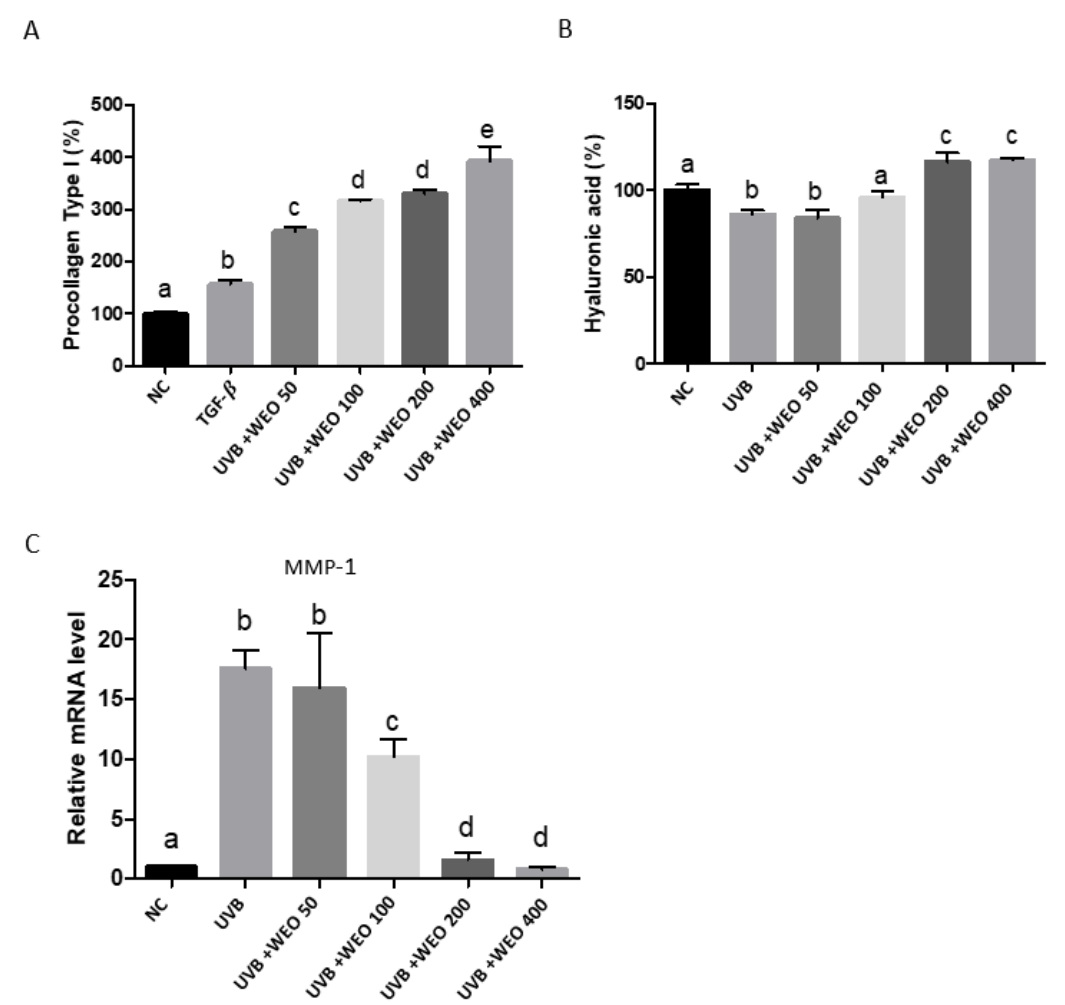
Figure 4. Changes in skin-damage-related factors in human skin cell lines. ( A ) Procollagen synthetic enhancement measurement in CCD-986sk cells by microplate reader. ( B ) Hyaluronic acid measurement in HaCaT cells. ( C ) Measurement of matrix metalloproteinase-1 (MMP-1) mRNA expression in CCD-986sk cells by qRT-PCR. Values with different letters are significantly different by ANOVA followed by the Newman–Keuls multiple range test ( p < 0.05). NC: normal control, UVB: Ultraviolet, WEO: wheat extract oil, HA: Hyaluronic acid.